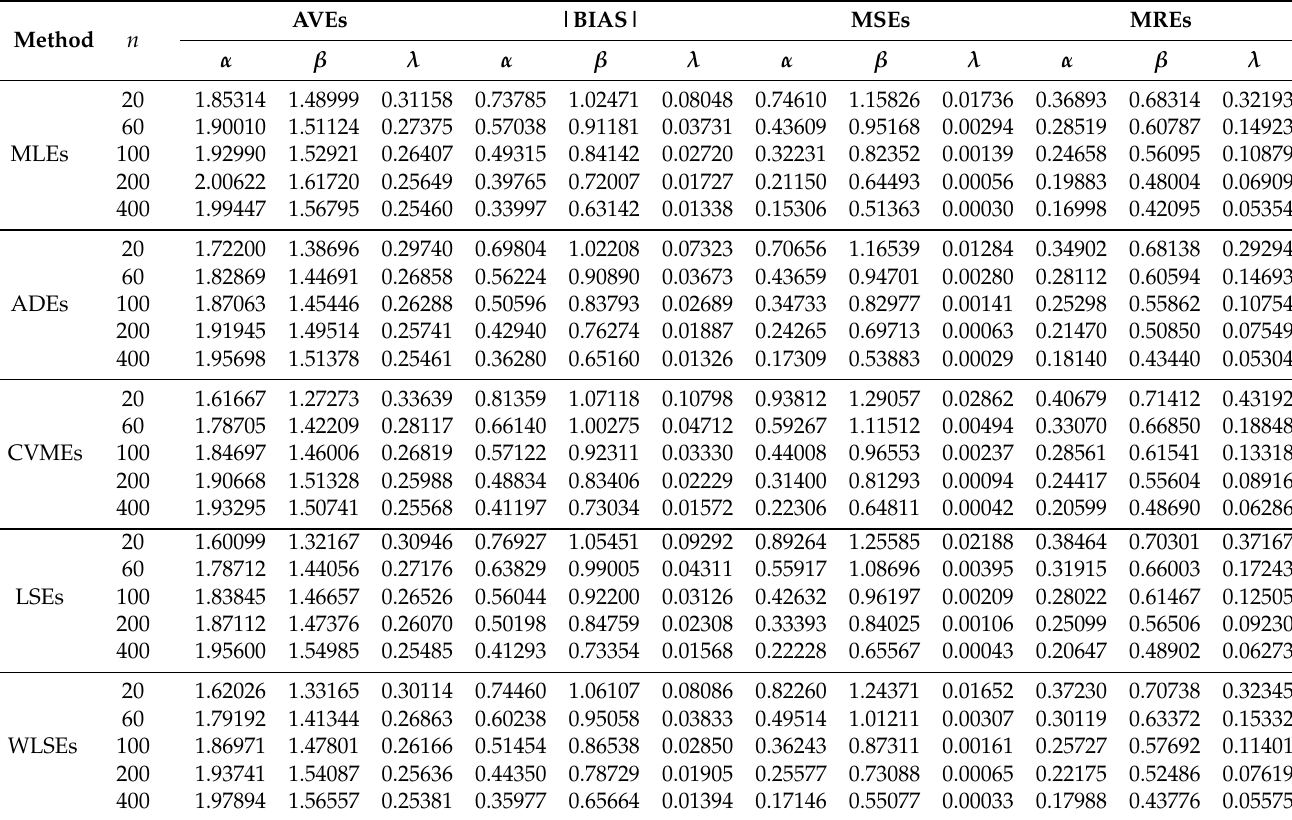
Table 4. Numerical values of the Ex-LL distribution for the parameters α = 2, β = 1.5, λ = 0.25.